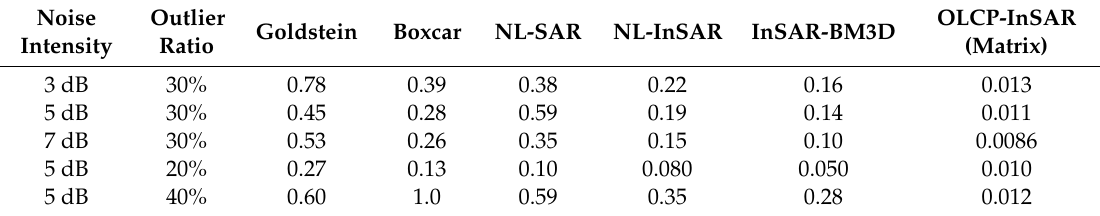
Table 3. MSE of a filtered interferogram with di ff erent noise conditions.